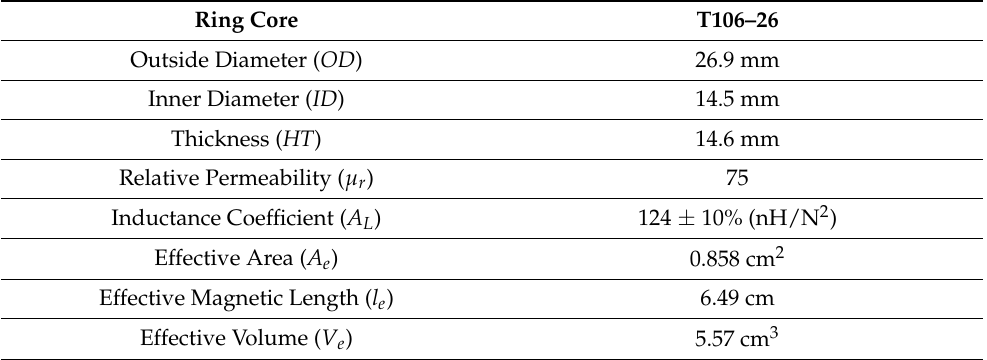
Table 5. Specifications for the used